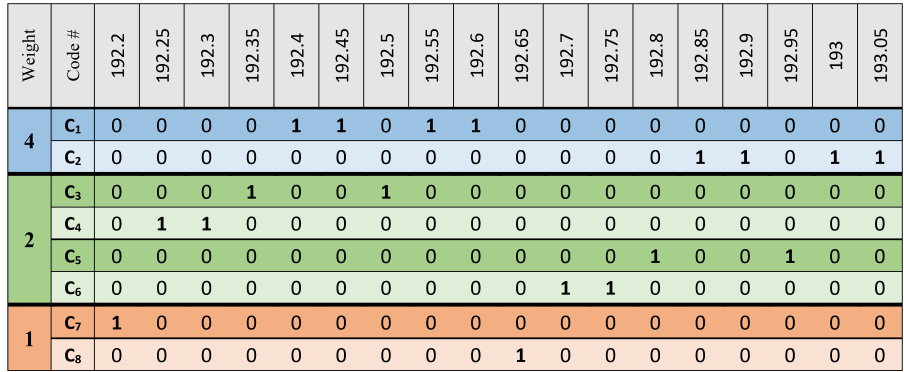
Figure 2. Codes composition for the proposed WON-OCDMA system for video surveillance, data and vibration services.